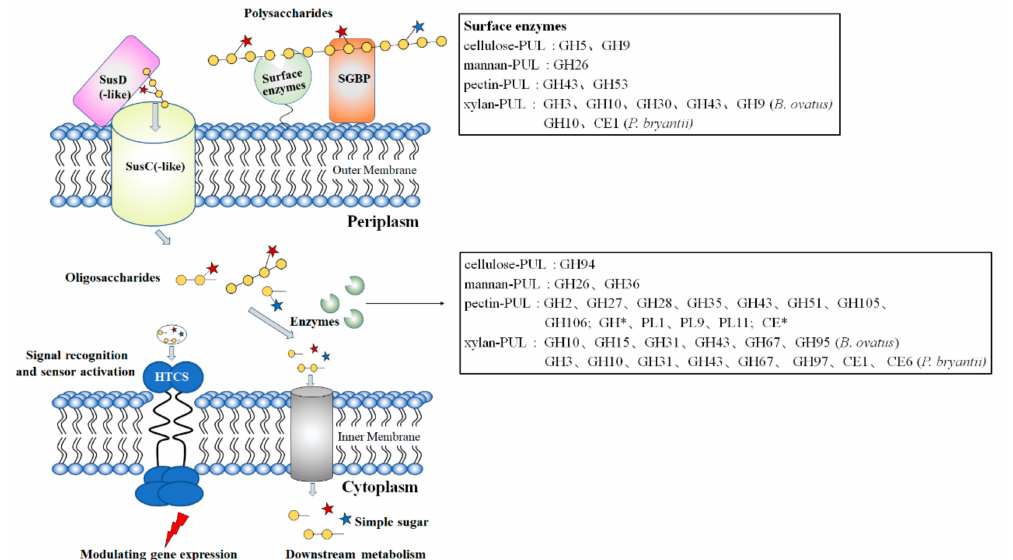
Figure 1. Schematic diagram of the Bacteroides polysaccharide utilization systems (PULs). Polysaccharide molecule is bound to a SGBP on the Bacteroides cell membrane surface and degraded into large fragments by the action of surface enzymes. Then the oligosaccharides, which are transported across the outer membrane and into the periplasmic space via the TonB-dependent transporter SusC/SusD-like for further processing. The oligosaccharides are subsequently hydrolyzed into simple sugar by the enzymes located in the cytoplasm space. The inner-membrane associated symporter protein transports the products into the cytosol for metabolism. The HTCS-like regulator is required to induce expression of the polysaccharide utilization genes through a series of signal cascade reactions. GH, glycoside hydrolase; PL, polysaccharide lyase; CE, carbohydrate esterase; *, new family. Yellow circles stand for the monosaccharides that form the backbone of a polysaccharide. The red and blue stars represent different groups on the side chain of the